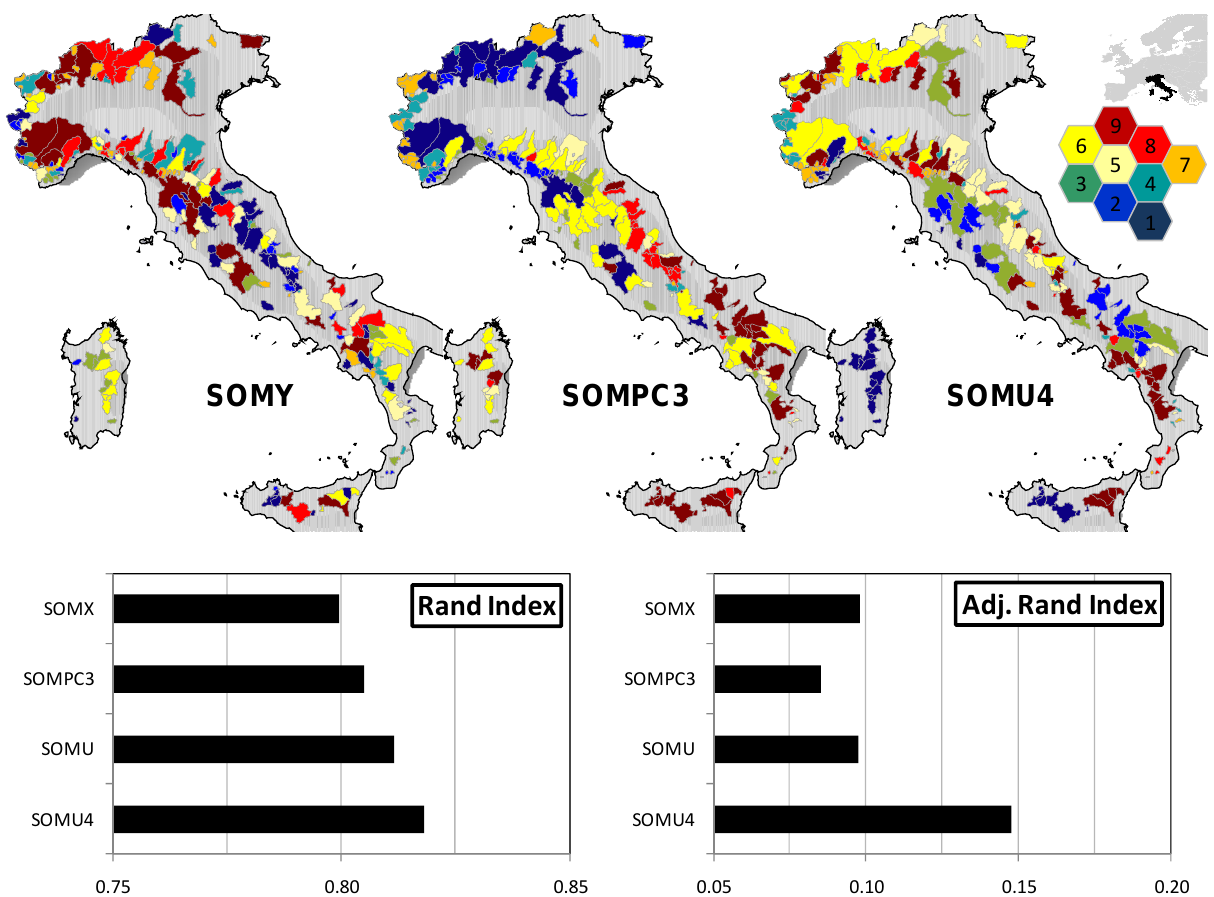
Fig. 5. SOM classifications of the study catchments (note that SOMU is omitted) and hexagonal topology of the output layer; bar-diagram for Rand and Adjusted Rand